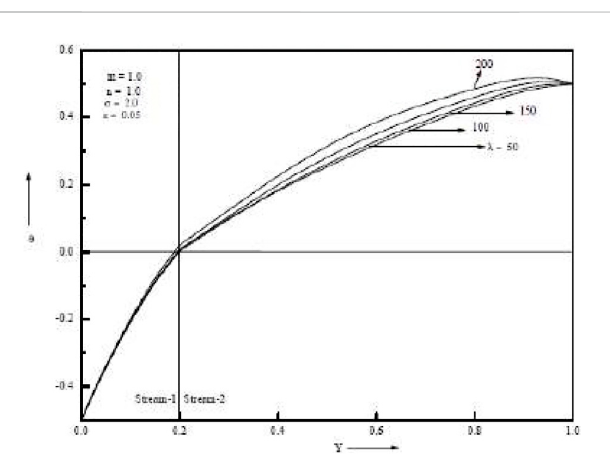
FIGURE 3 Velocity for various mixed convection values λ = 50, 100, 150, 200.